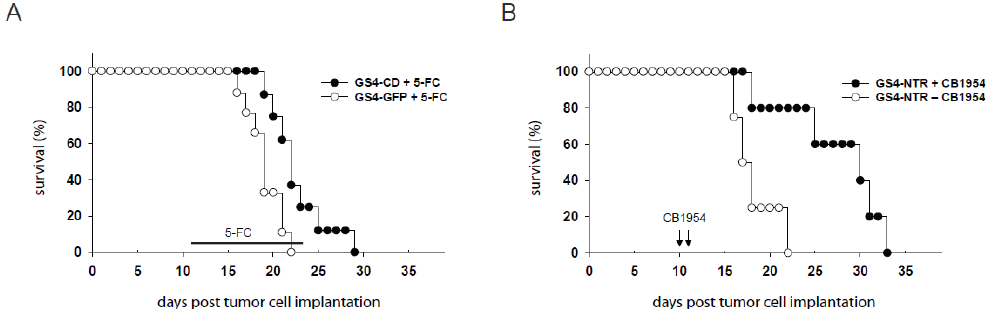
Figure 4. Survival analysis of immune-competent rats bearing intracerebral RG-2 gliomas. ( A ) GS4- CD or GS4-GFP was stereotactically injected into pre-established intracerebral RG-2 tumors three days after tumor inoculation. Eight days after viral vector inoculation, the rats received intraperitoneal injections of 5-FC (100 mg/kg), once every other day, for a total of 7 treatments. Survival curves were constructed for two treatment groups: GS4-CD plus 5-FC, and GS4-GFP plus 5- FC. ( B ) GS4-NTR was stereotactically injected into pre-established intracerebral RG-2 tumors three days after tumor inoculation. Seven and eight days after viral vector inoculation, the rats received daily intraperitoneal injections of CB1954 (2.5 mg/kg) or PBS. Survival curves were constructed for two treatment groups GS4-NTR plus CB1954 and GS4-NTR plus